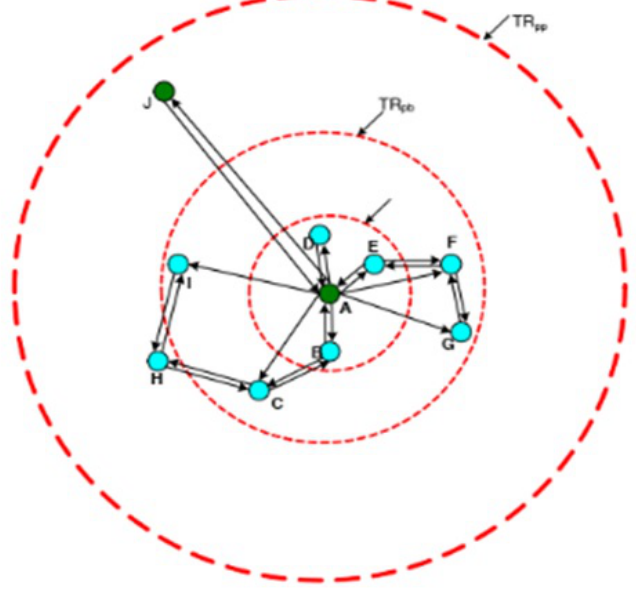
Figure 4. An example of the candidate selection